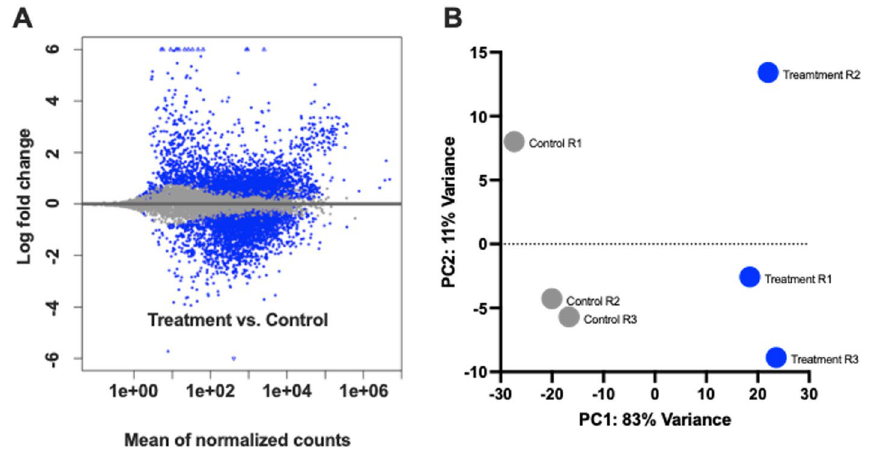
Figure 3. ( A ) Scatterplot of log fold changes vs. mean normalized counts generated using HTSeq and DESeq2 for Plasmodium falciparum sporozoite infected treatment and naïve control library replicates ( p < 0.05). ( B